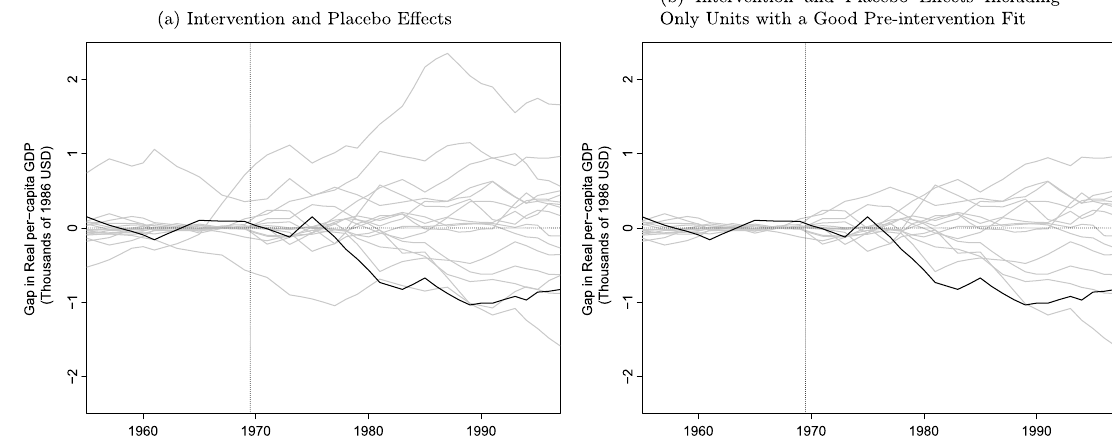
Figure 1: Estimated Effects using the Synthetic Control Method. Note: While the gray lines show the estimated placebo effect for each Spanish region, the black lines show the estimated impact of ETA’s terrorism on the Basque Country’s economy. A good pre-intervention fit is defined as a pre-intervention MSPE at most five times greater than the Basque Country’s pre-intervention